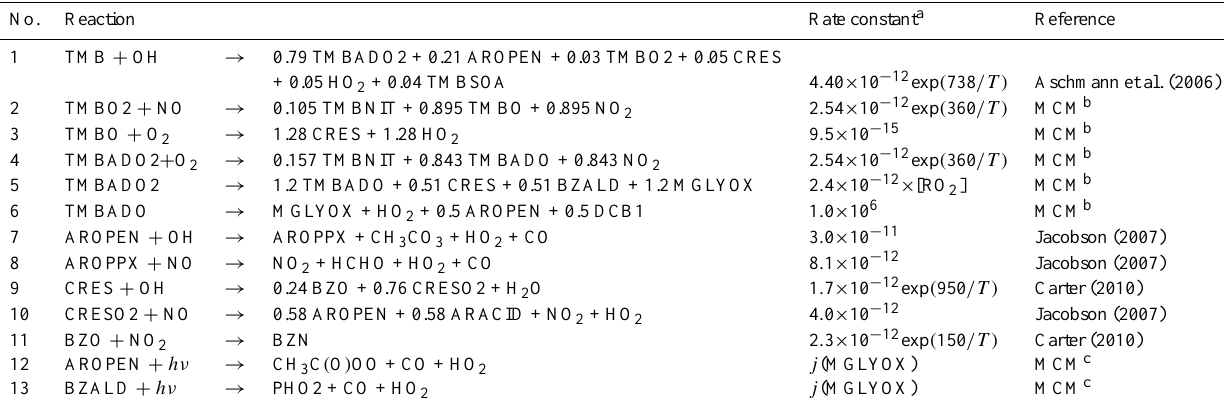
Table 2. Simplified reaction mechanism for 1,3,5-trimethylbenzene used in this study. The degree of detail of this mechanism corresponds to the aromatic hydrocarbon chemistry scheme by Jacobson (1997).